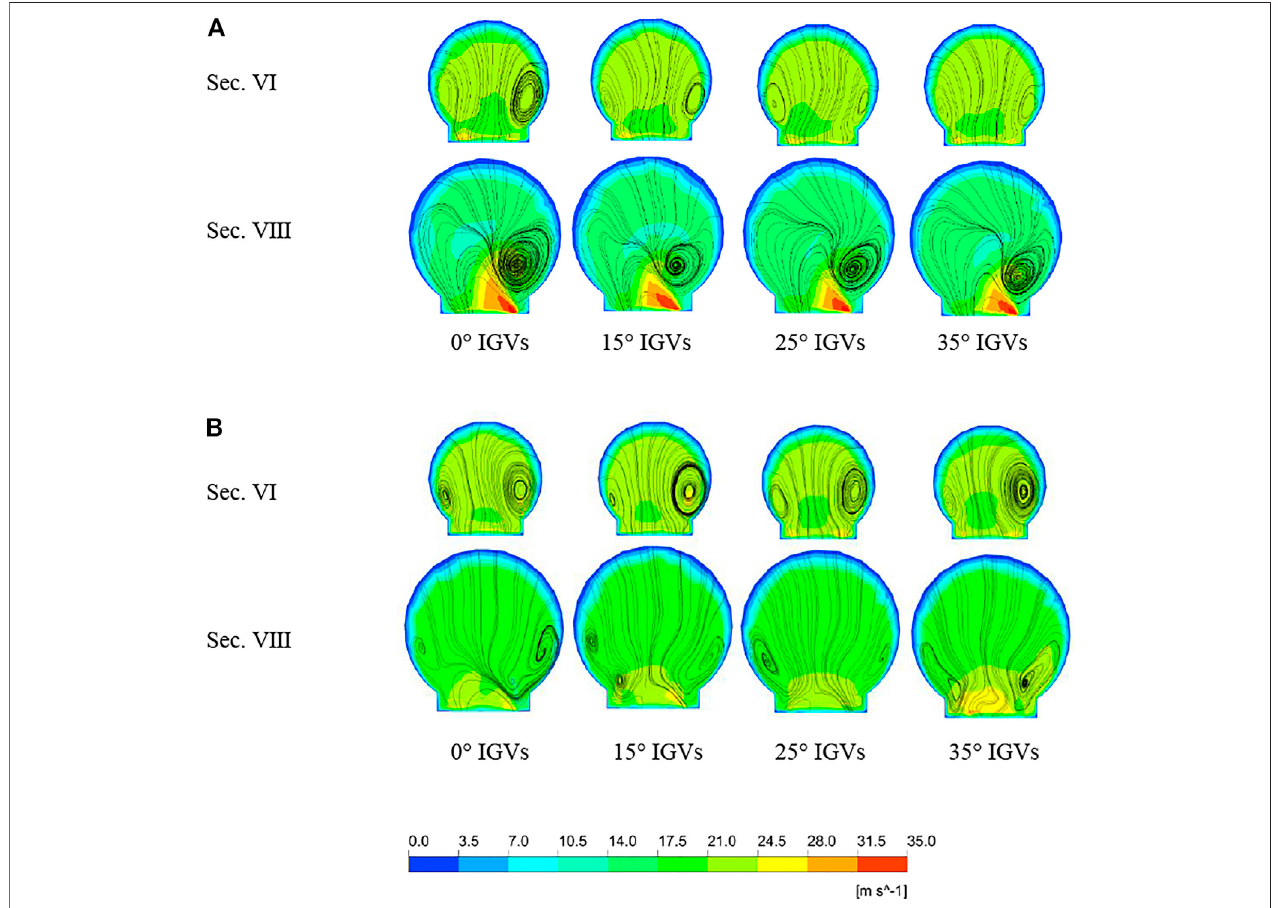
FIGURE 8 | Velocity contours and streamlines of four pump sections under two operating points. (A) 0.6Qd and (B) 0.8Qd.